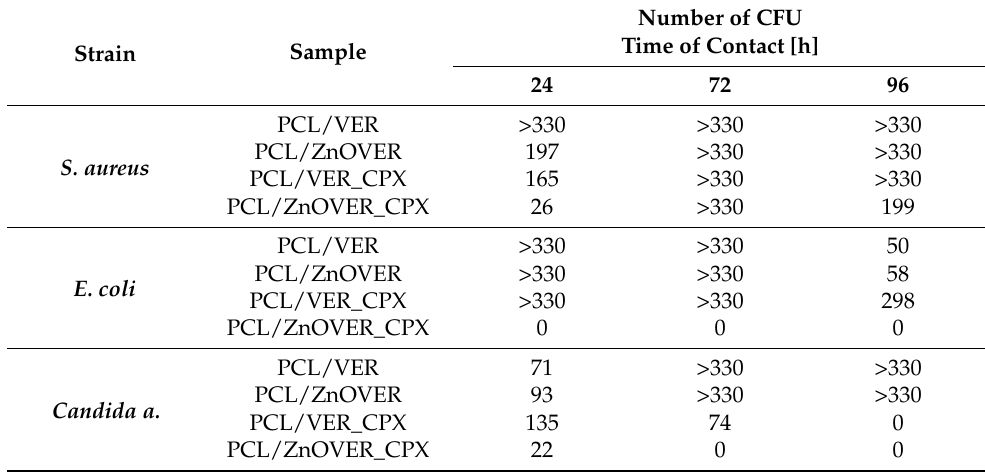
Table 6. Average numbers of fungal colony-forming units (CFU) of used strains at the various time intervals for thin PCL/clay nanocomposite films.